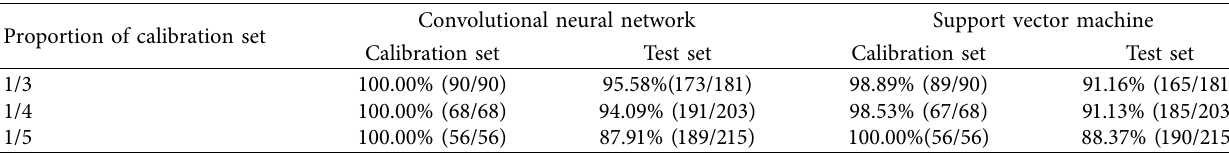
Table 9: The classification results of the calibration set and the test set based on the different number of samples in the calibration set by random method.